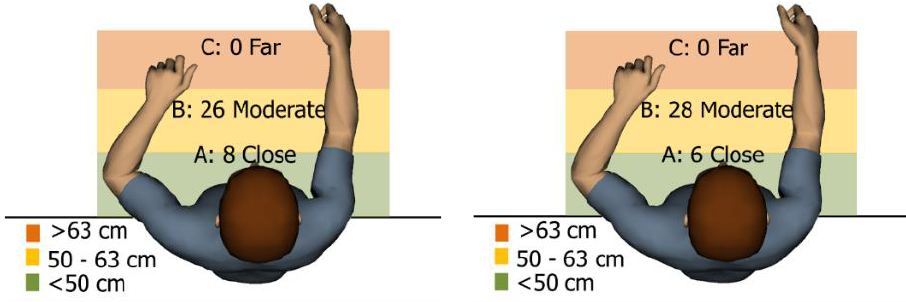
Figure 5. Number of forward reaches during the assembly process of product P1.